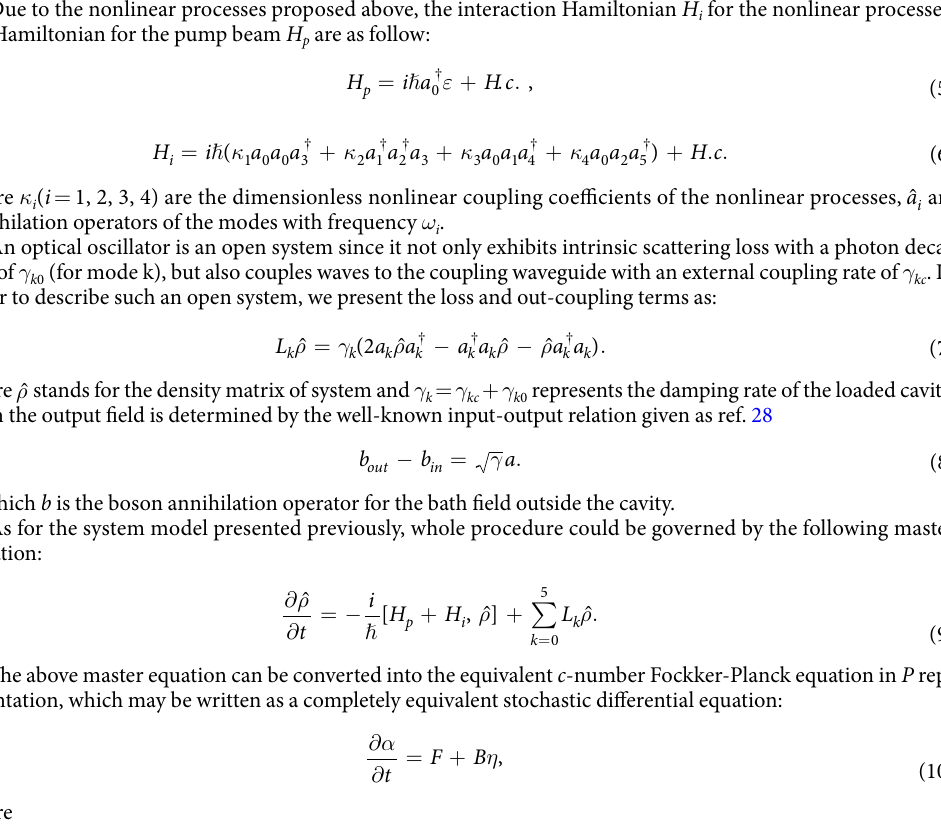
1.742 μ m . The structure of the PPLN OS is shown in Fig. 3(b), where the index of refraction of the black blocks is negative and the index of refraction of the white blocks is positive. The unit of length in Fig. 3b is micrometer. Since the structure of the PPLN crystal is obtained, we design a schematic diagram of physical system as shown in Fig. 3. The system is pumped by a continuous-wave pump laser at 1064.45 nm, amplified by a Yb:fiber amplifier. Then the pump beam enters the cavity through a plane coupling mirror, while other mirrors are